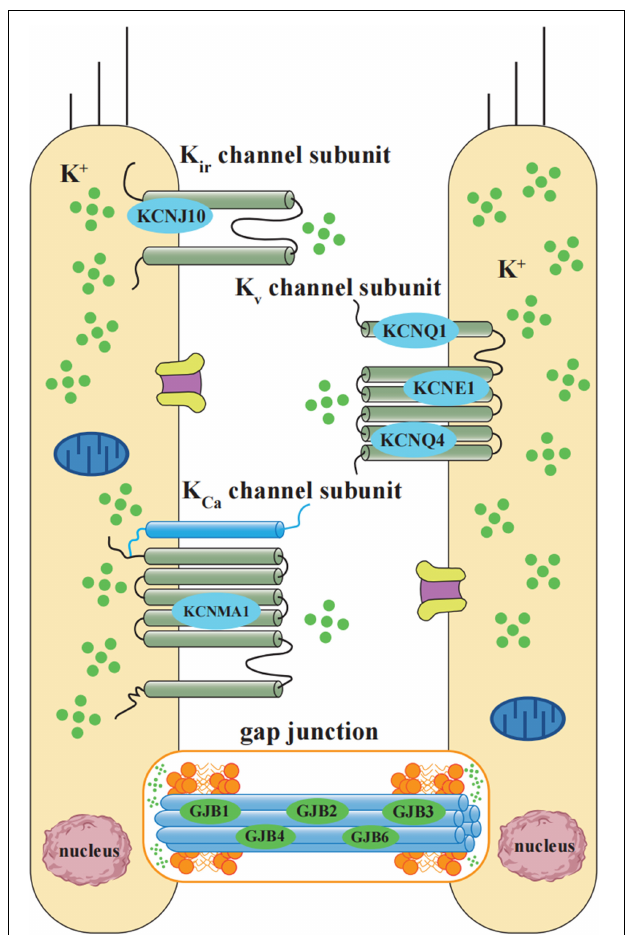
FIGURE 2 | Schematic diagram of potassium ion cycling related NIHL susceptibility genes. K + cycling related NIHL susceptibility genes include K + channel proteins and gap junction proteins. According to the operational mechanism and structures, NIHL susceptibility related K + channels can be classified into 3 groups: inward rectifier (K ir , including KCNJ10 ), voltage-gated (K v , including KCNQ1 , KCNE1 , and KCNQ4 ), and Ca 2 + activated (K Ca , including KCNMA1 ). Gap junctions between hair cells and non-sensory cells are primarily formed by a family of connexin proteins, which is encoded by gene GJB1 , GJB2, GJB3, GJB4, and GJB6. Gap junction-mediated intercellular communication plays an essential role in K +